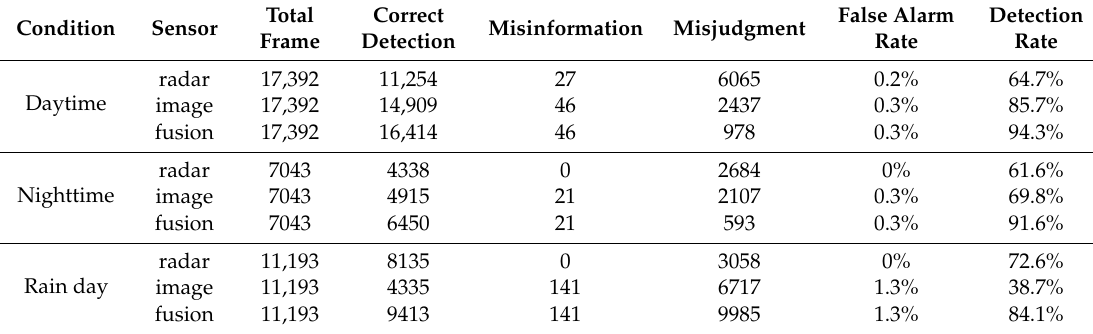
Table 4. Detection results of each system under di ff erent weather conditions.